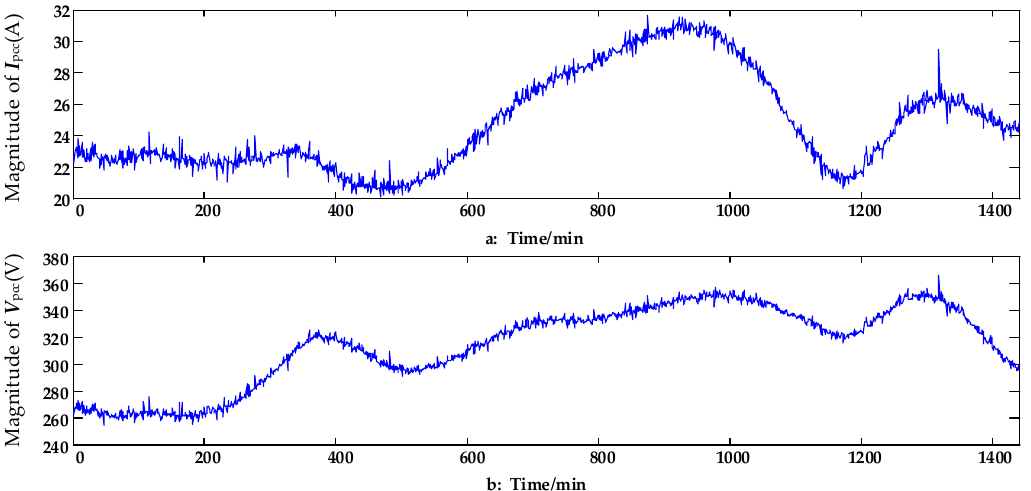
Figure 6. ( a ) The waveform of the harmonic current at PCC ( k = 0.2, p = 10); ( b ) The waveform of the harmonic voltage at PCC ( k = 0.2, p = 10).